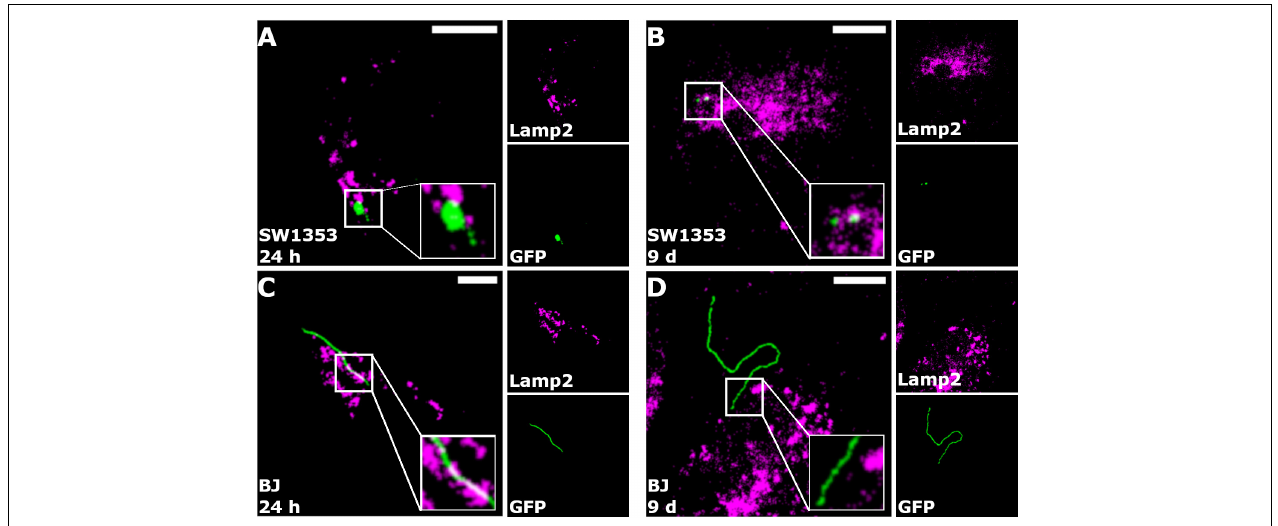
FIGURE 6 | Borrelia burgdorferi did not co-localize with lysosomes. Merged representative images of SW1353 (A,B) and BJ (C,D) cells infected with B. burgdorferi at 24 h and 9-day time points, respectively. Borrelia fluorescence green, lysosomes in magenta, and co-localized pixels appear white. Zoomed images are shown in the white boxes at the bottom right corners of the merged images. As indicated in the merged images, co-localization of B. burgdorferi with lysosomes was not observed. Intermodes threshold was applied to the images before analysis with JaCoP plugin in ImageJ. Scale bars 10 µ m.